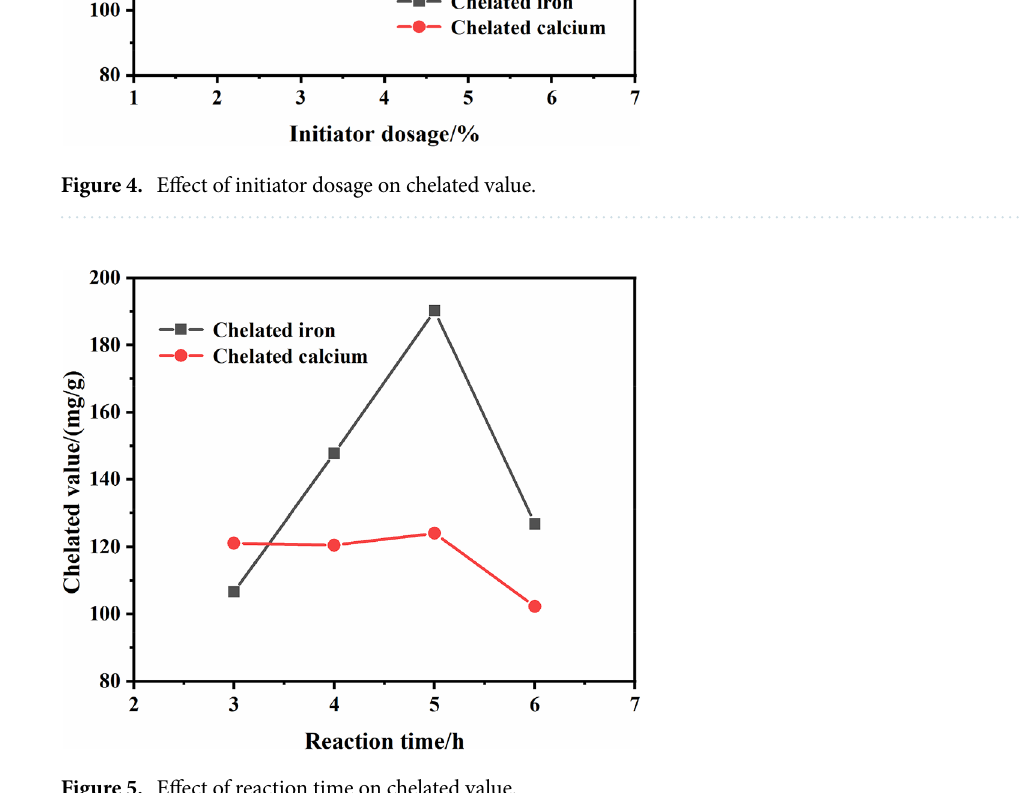
Figure 5. Effect of reaction time on chelated